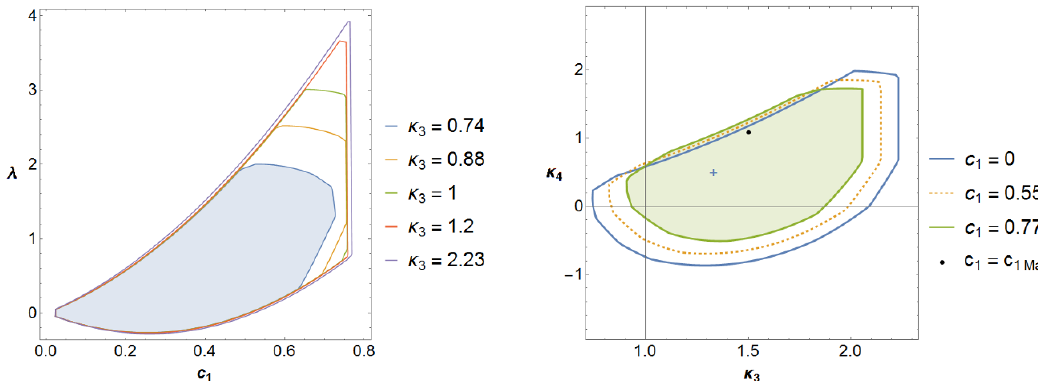
Figure 5 . Relation between the bounds from hh ! hh and hf ! hf . Left: the allowed region of parameters ( (cid:21); c 1 ) obtained from combining positivity bounds from both hh ! hh and hf ! hf scatterings in the Z 2 symmetry case. The largest allowed parameter region is obtained from (cid:20) 3 = 2 : 23 and the smallest | from (cid:20) 3 = 0 : 74 (shaded). In all cases we recover (cid:21) = 0 when c 1 = 0. Right: the allowed region of ( (cid:20) 3 ; (cid:20) 4 ) obtained from the hh ! hh scattering in the Z 2 symmetric case. The island starts to shrink as c 1 increases until it reaches c Z 2 = 0 : 77 (green). The bounds obtained 1max from the hf ! hf scattering amplitudes forbids the shrinking of the island to a point which would occur at c 1max = 1 : 23. The minimal model with (cid:20) 3 = 4 = 3, (cid:20) 4 = 1 = 2 is depicted by a